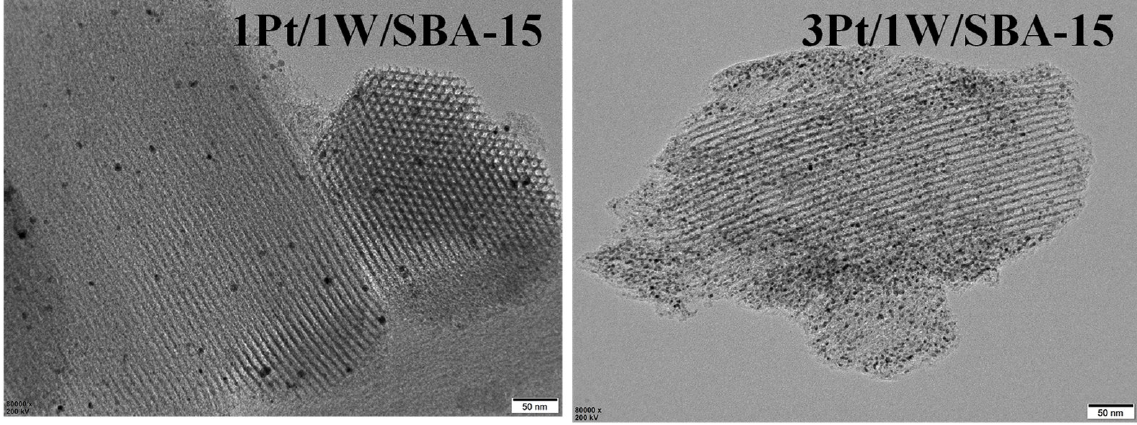
Figure 2. TEM images of 1Pt/1W/SBA-15 and 3Pt/1W/SBA-15. These catalysts showed weak FT-Raman spectral bands at 972 and 496 cm − 1 due to isolated WO x species (Supplementary Materials, Figure S4) [27,28]. The high dispersion